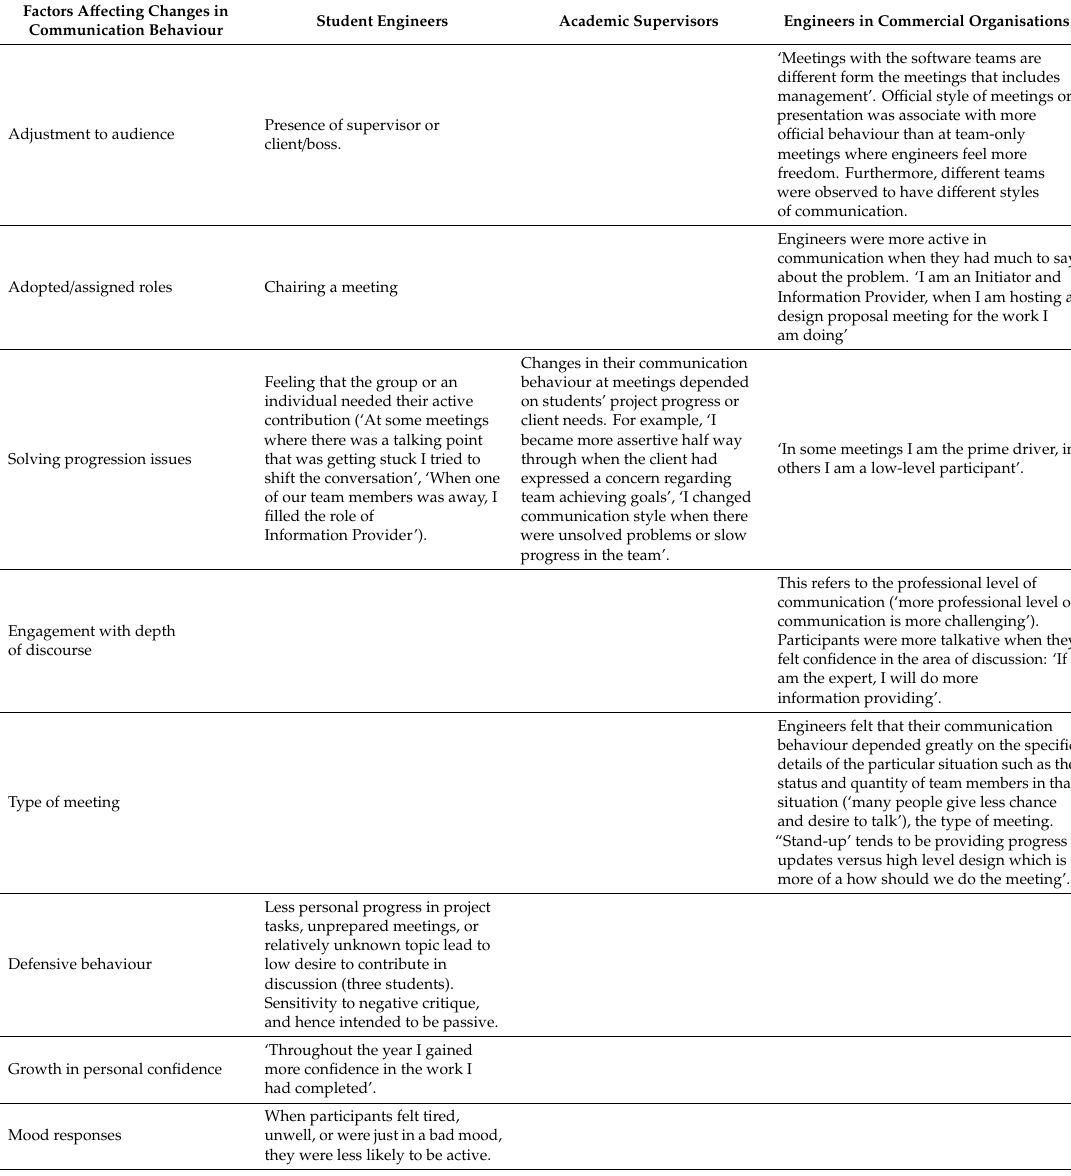
Table 2. Communication adjustment factors for student engineers, academic supervisors and engineers in commercial